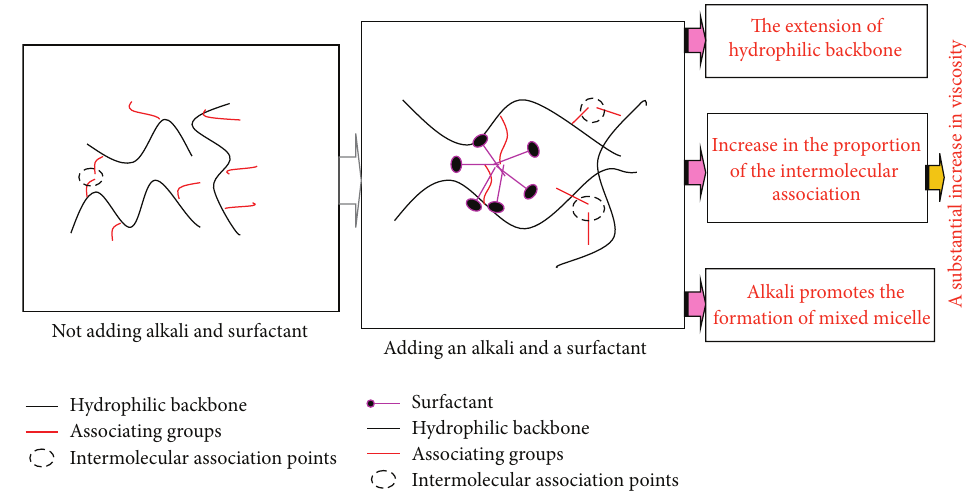
Figure 12: The effect of alkali mixed surfactant on the status of the associating polymer